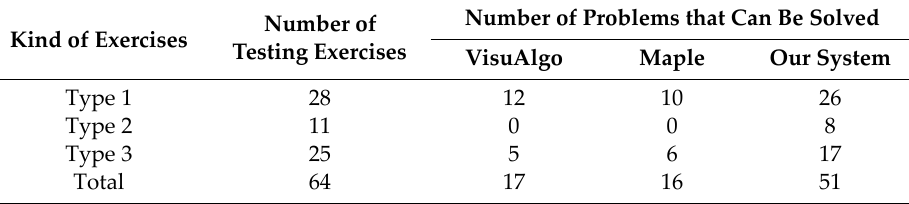
Table 6. The ability for solving exercises in graph theory